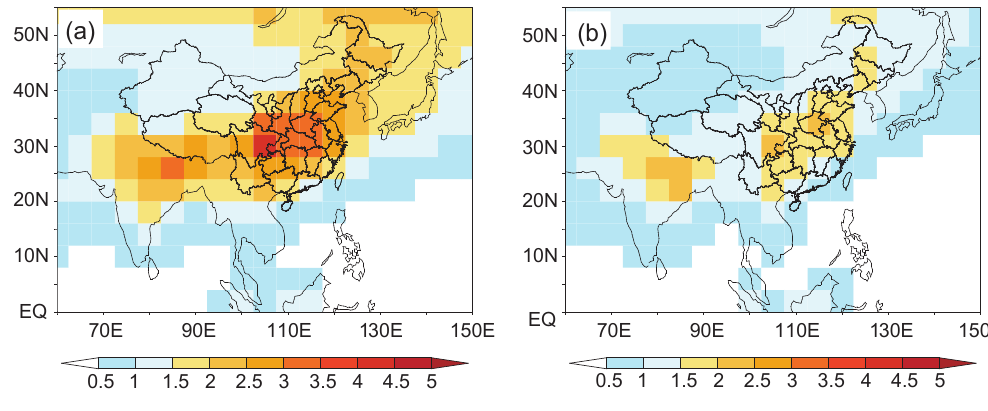
Fig. 2. Simulated summer (JJAS) mean tropospheric column burden OC. (a) 1998; (b) 2002. Unit: mgm − 2